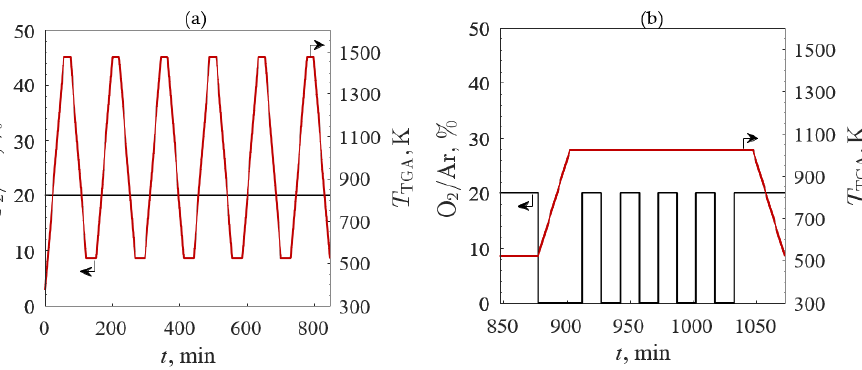
Figure 4. O 2 concentration in Ar (black line) and temperature (red line) profiles versus time with the ( a ) temperature-swing between 523 and 1473 K in 20% O 2 / Ar and ( b ) O 2 pressure-swing between 20% ( a ) temperature-swing between 523 and 1473 K in 20% O 2 /Ar and ( b ) O 2 pressure-swing between 20% O 2 / Ar and 100% Ar at 1023 K for the third TGA O 2 /Ar and 100% Ar at 1023 K for the third TGA screening.